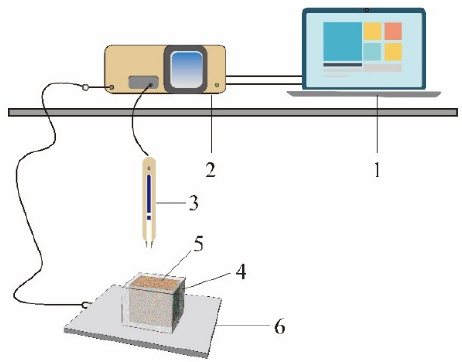
Figure 2. Testing system of straw compost electrical property. (1) Computer; (2) LCR meter; (3) LCR digital bridge test line; (4) acrylic box; (5) sample; (6) aluminum plate. The impedance analyzer was preheated for 30 min, and the LCR digital bridge test line was calibrated for short-circuit and breakage as well as for 50 Ω load. For the meas- urement, the excitation voltage was first set to 1 V. The impedance analyzer was used to measure the empty cylinder capacitance C 0 at 113 logarithmic frequencies ranging from 1 to 100 kHz, and then, the prepared samples were placed into a homemade capacitor. The empty capacitance value of the capacitor ( C 0 ), the parallel equivalent capacitance of